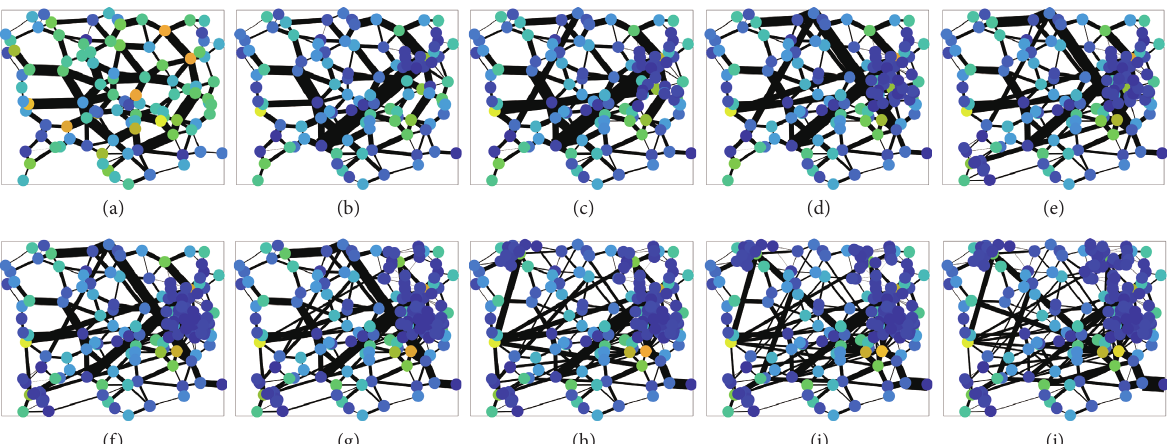
Figure 8: The growth of multilayer network and redistribution of population and traffic flow, increasing from the top left to bottom right with ten times of iterations.